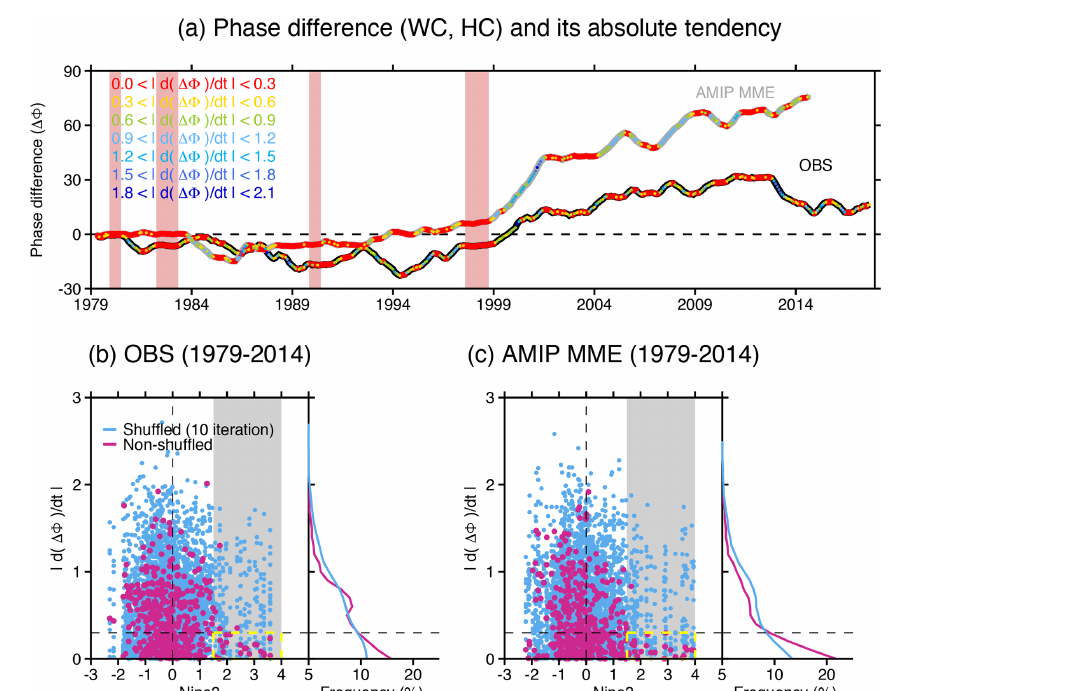
Figure 2. SST-forced phase-synchronized spatial shifts of the HC and WC. (a) The smoothed (i.e, 7-month running mean) phase difference between PC time series of WC2 and HC1 (position of dots) and its absolute tendency (color of dots), obtained from the ERAI observational data (1979–2017; black) and AMIP MME (1979–2014; gray). Here, the phase is calculated from the analytical signal of the PCs using the Hilbert transform (see section on the method for detail). The phase-synchronized (PSYN) months are measured by the criterion that the absolute tendency of phase difference is less than 0.3 ◦ /month. The red vertically shaded zone indicates PSYN periods that are identical for both observations and the AMIP MME. (b, c) The absolute tendency of WC–HC phase difference as a function of Niño3 SST anomaly (pink), obtained from the (b) observations and (c) AMIP MME. Sky-blue dots indicate tendencies calculated from the randomly shuffled PCs. The frequency histogram of the absolute tendency of the WC–HC phase difference is also vertically plotted in each right